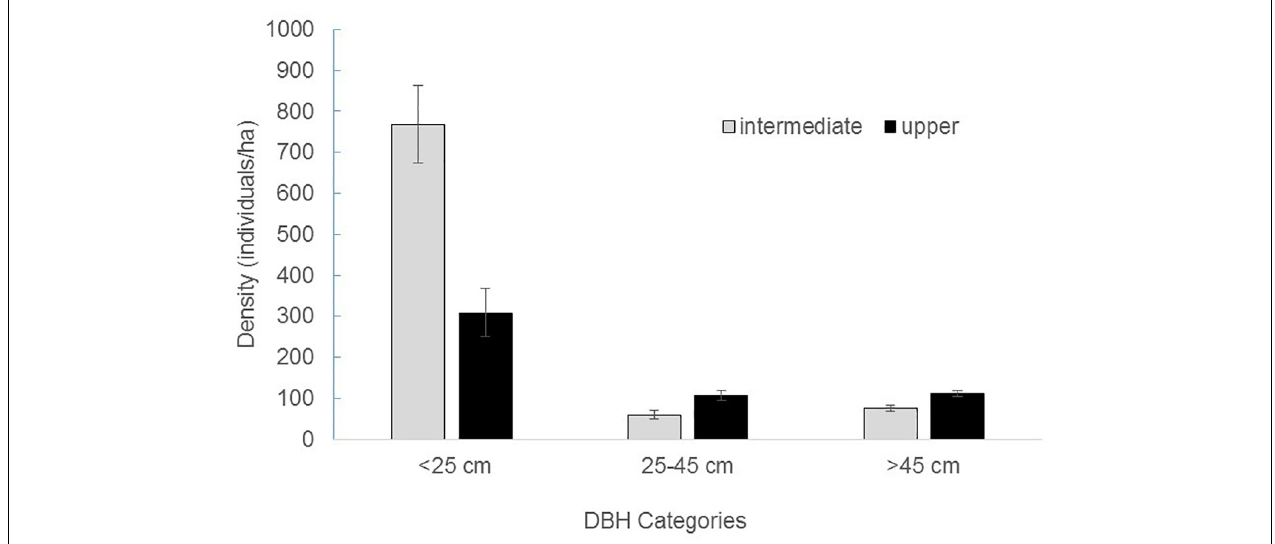
FIGURE 7 | Average density (individuals/ha) of adult trees in each diameter category per elevational